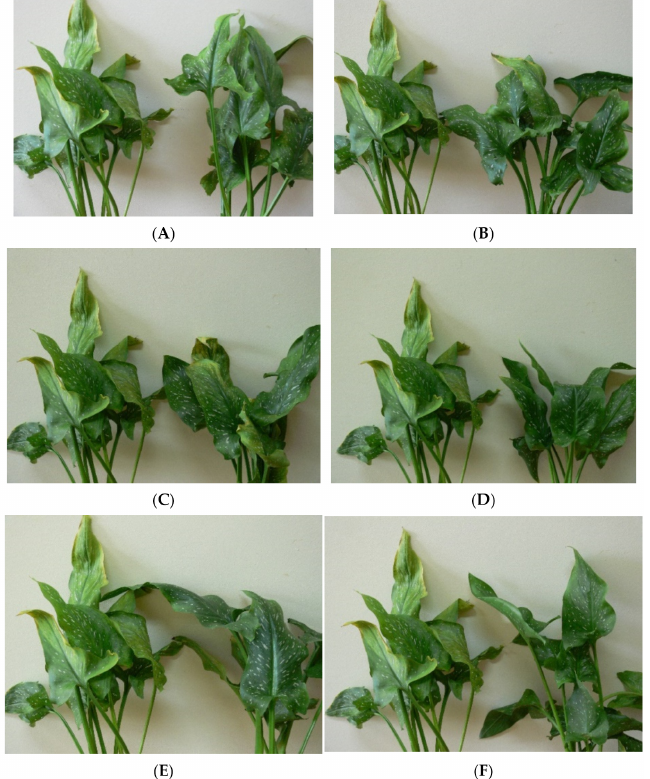
Figure 2. Leaves of Zantedeschia ‘Albomaculata’ 6 days after conditioning and insertion into water. ( A )—from left—control leaves, from right—conditioned in MemT at concentration of 25 mg dm − 3 ; ( B )—from left—control leaves, from right—conditioned in MemT at concentration of 50 mg dm − 3 ; ( C )—from left—control leaves, from right—conditioned in MemT at concentration of 75 mg dm − 3 ; ( D )—from left—control leaves, from right—conditioned in MemTR at concentration of 25 mg dm − 3 ; ( E )—from left—control leaves, from right—conditioned in MemTR at concentration of 50 mg dm − 3 ; ( F )—from left—control leaves, from right—conditioned in MemTR at concentration of 75 mg dm − 3